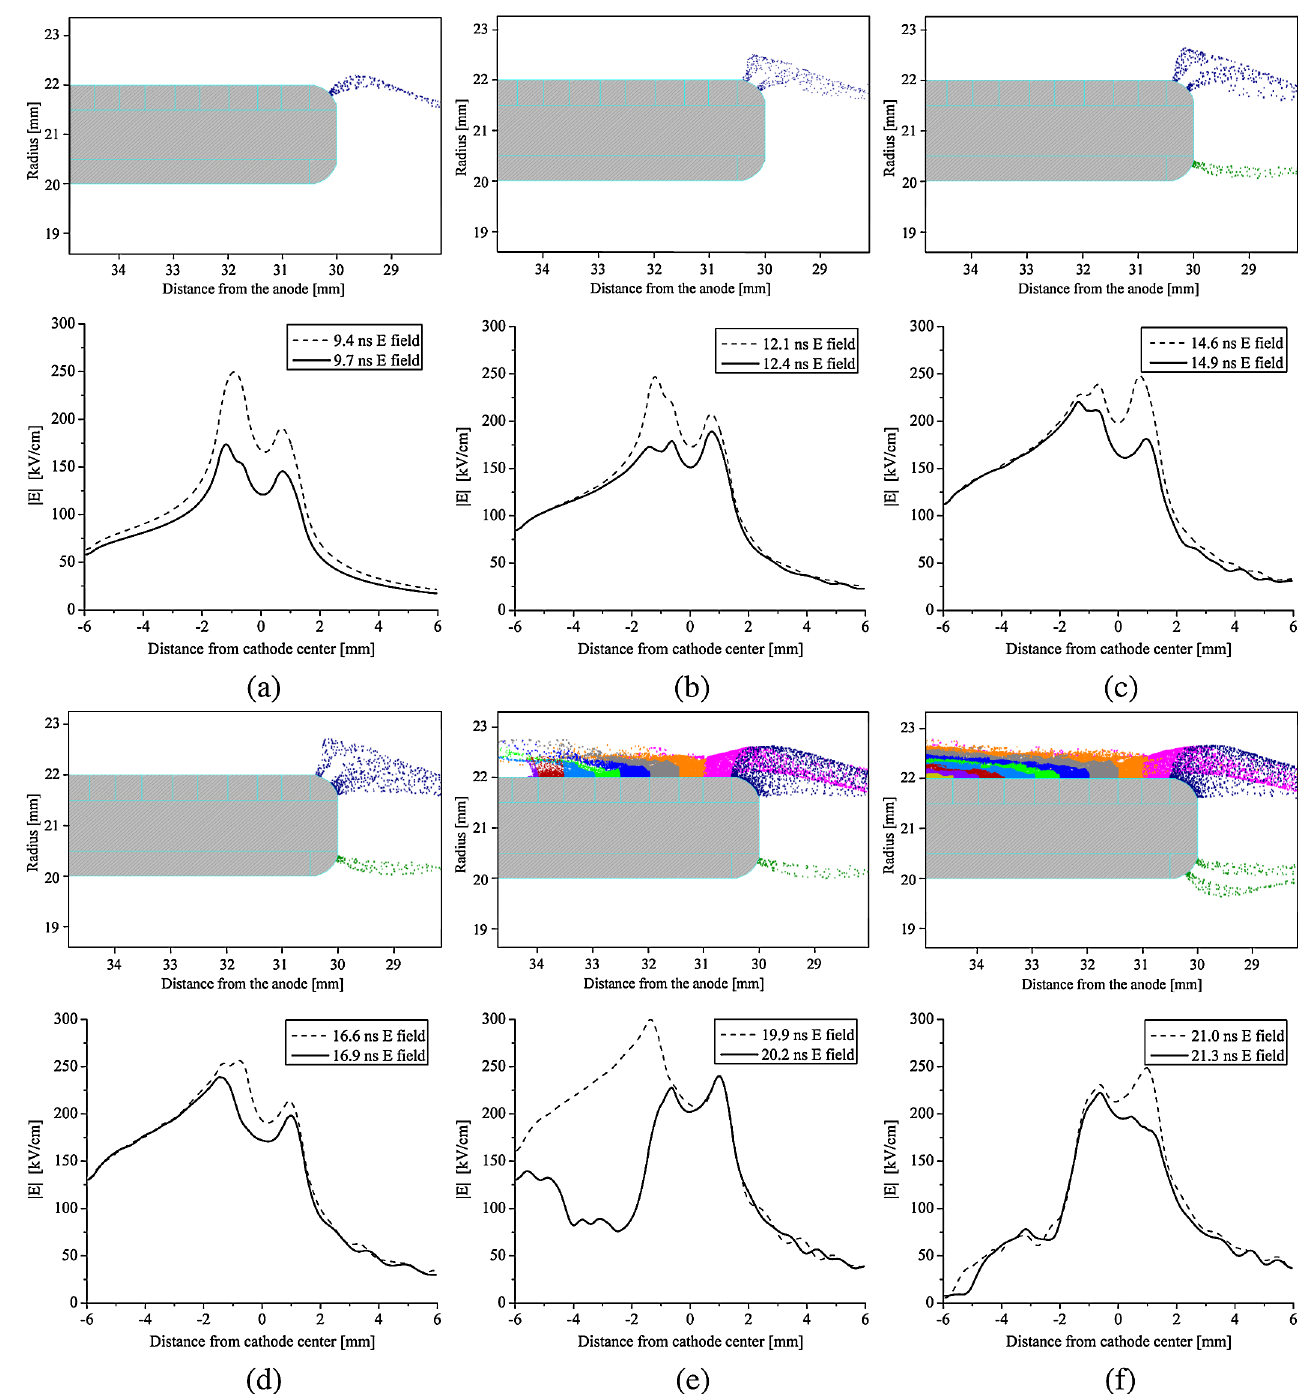
FIG. 5. (Color) Depression rate of the magnitude of the electric field and the emission area by the emission step. Each step represents the moment of the increase of the emission area. (a) 1st step (140 kV) emission, (b) 2nd step (200 kV) emission, (c) 3rd step (250 kV) emission, (d) 4th step (310 kV) emission, (e) 5th step (400 kV) emission, and (f) 6th step (430